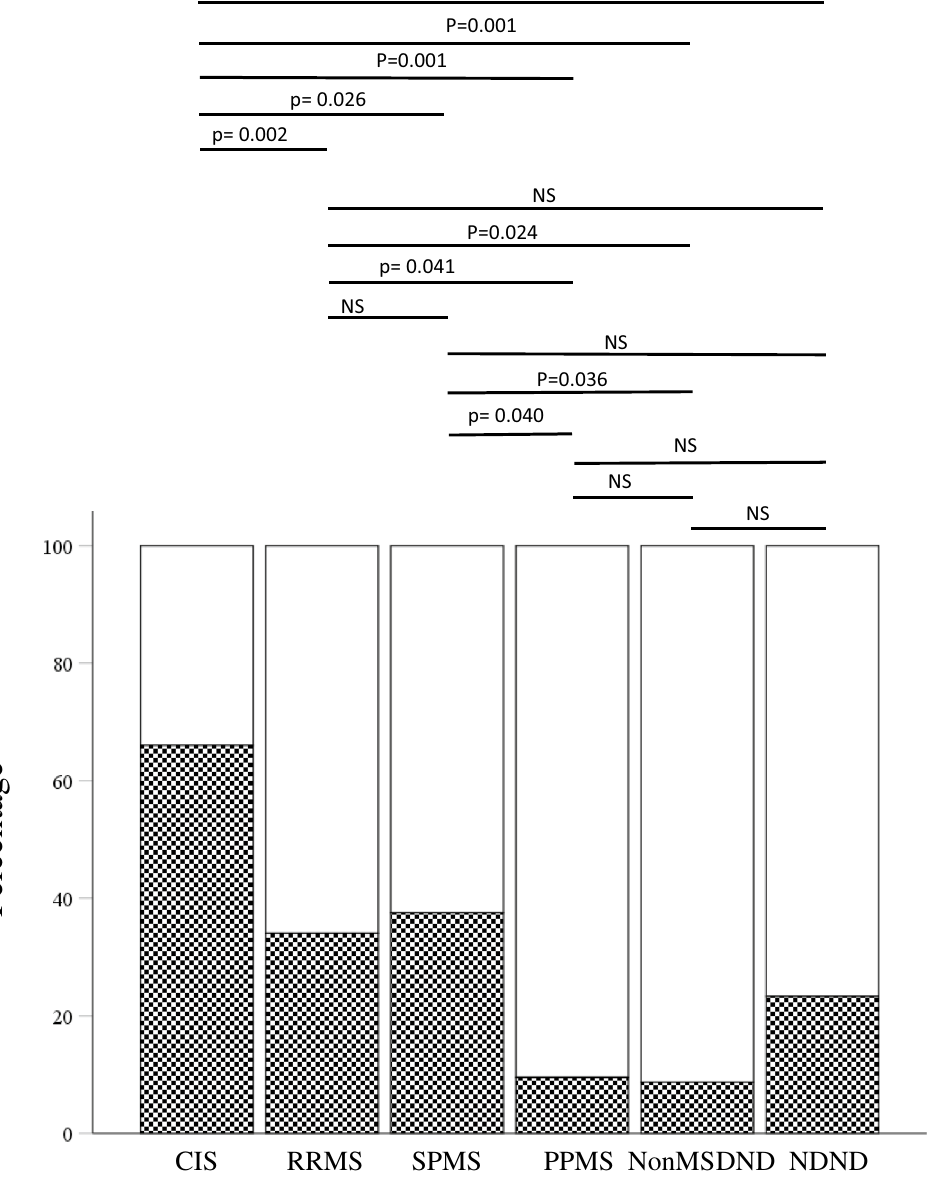
Figure 3. Percentage of intrathecal IgA synthesis in MS groups using isoelectric focusing and immunodetection. White area represents the percentage of individuals of each group without IAS. Squared areas represent the percentage of individuals with IAS. CIS clinically isolated syndrome, RRMS relapsing–remitting